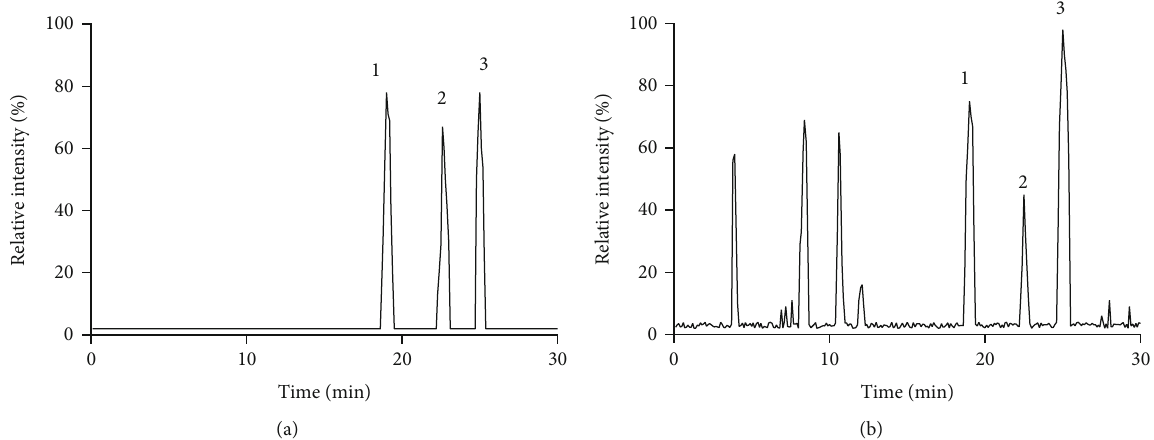
Figure 1: GC analysis of cod-liver oil: (a) standard solution; (b) sample solution; 1: EPA methyl ester; 2: C23:0 methyl ester; 3: DHA methyl